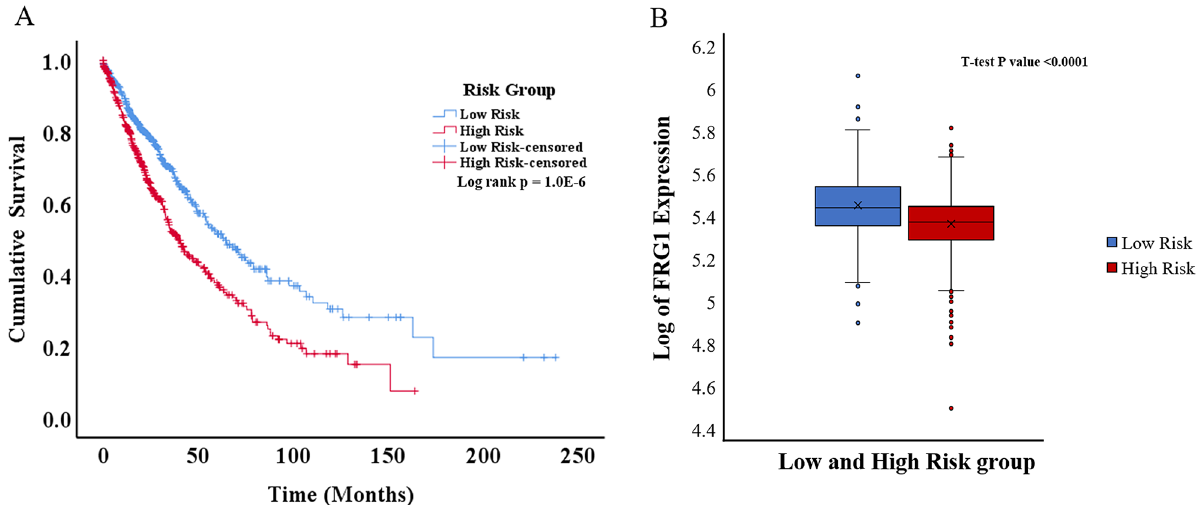
Figure 4. Kaplan–Meier plot and box plot of lung cancer patients risk groups based on the multigene model. ( A ) KM plot showing overall survival in low-risk and high-risk patient groups (Log-rank test p-value = 1.0E−6). Blue line shows the low-risk group and the red line shows the high-risk group. ( B ) Box plot showing log of FRG1 expression level in low and high-risk groups. The Y-axis represents the log of FRG1 expression and the X-axis shows the group.